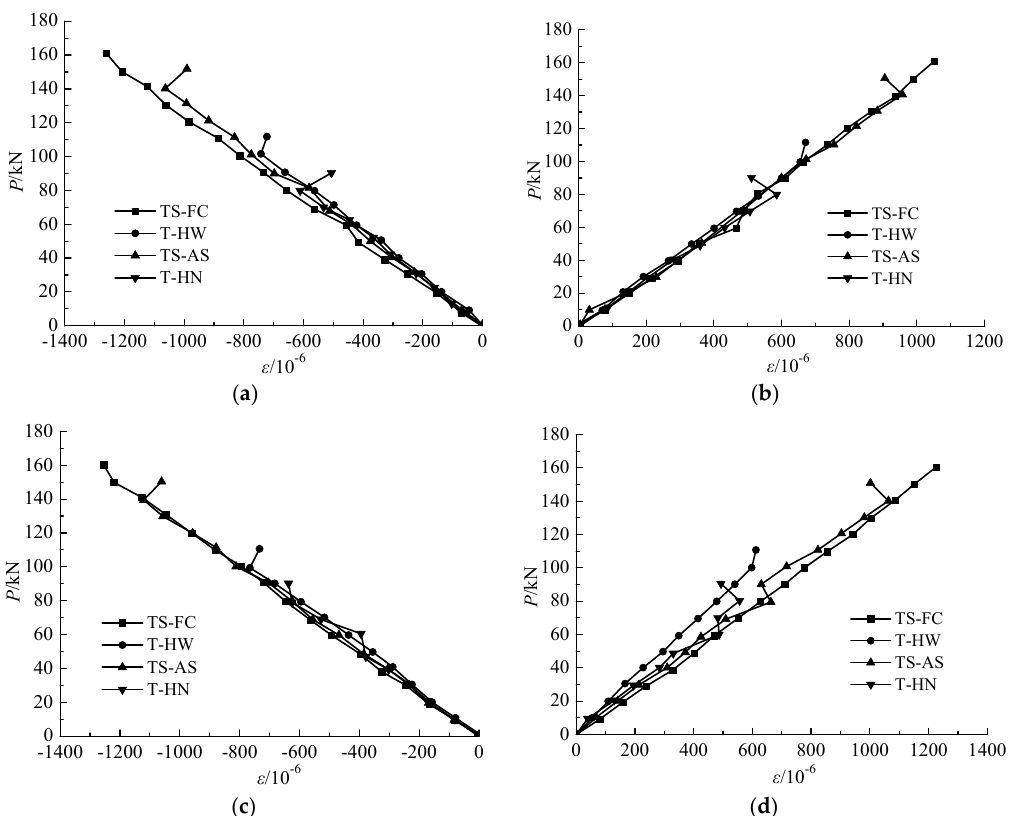
Figure 10. Total vertical loading–axial strain curves of diagonal braces. ( a ) Diagonal brace ‘jp’; ( b ) Diagonal brace ‘jo’; ( c ) Diagonal brace ‘ip’; ( d ) Diagonal brace ‘io’.